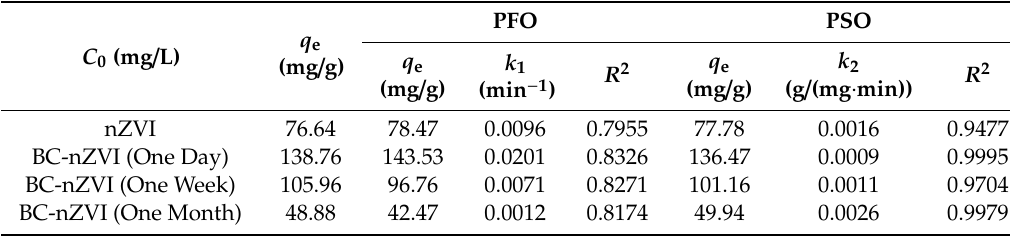
Table 2. Comparison of total Cr removal with different materials reported in the literature.